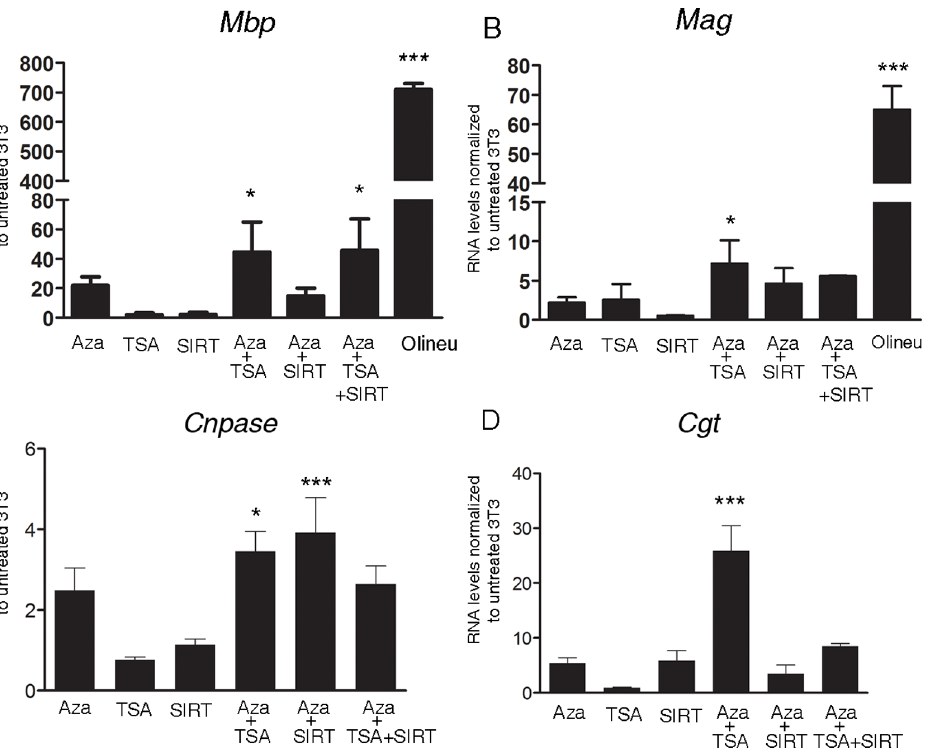
Figure 4. Endogenous myelin gene expression in fibroblasts can be elicited by global pharmacological epigenetic modulators. NIH3T3 cells were treated with the DNA demethylating agent, 5-azacytidine (5-AzaC), and/or with the histone deacetylases inhibitors trichostatin A (TSA) and sirtinol. The transcript levels of Mbp (A), Mag (B), Cnpase (C) and Cgt (D) were analyzed by qRT-PCR. Endogenous myelin genes were expressed in fibroblasts treated with 5-AzaC and TSA, but not in untreated cells, even though they did not reach the levels of myelinating cells (Oli neu cells in A and B). Also, treatment with 5-AzaC/sirtinol was less effective than 5-AzaC/TSA. Experiments were performed on three independent cultures. Results are expressed as mean 6 standard error (SE) and statistically compared with the levels detected in untreated NIH3T3 cells using a one way ANOVA test followed by post hoc analysis. (*p , 0.05, **p , 0.01, ***p , 0.001).